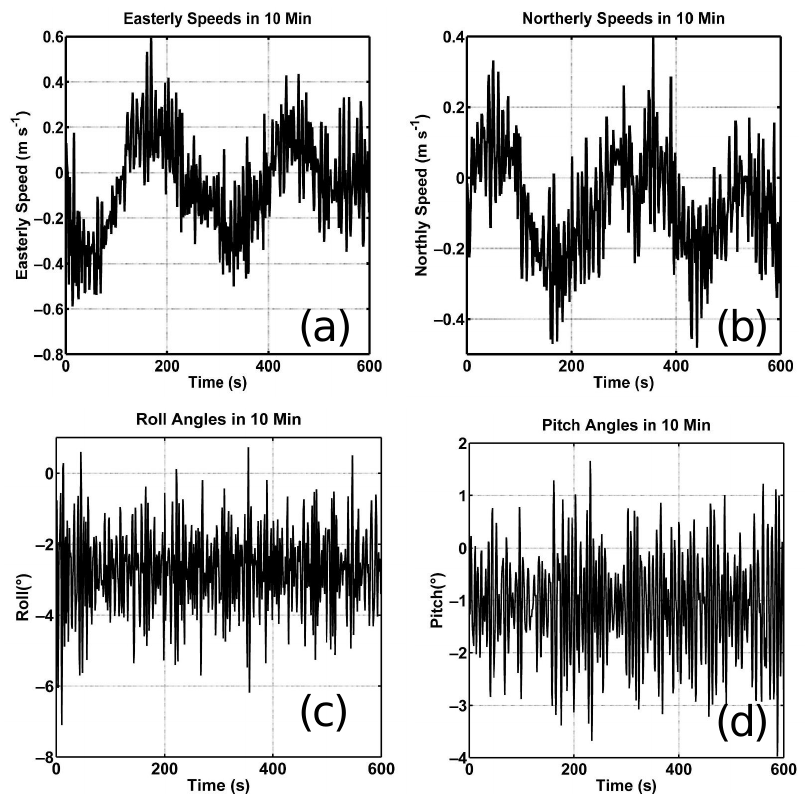
Figure A1. In the first 10 min (time span 1 s): ( a ) easterly speeds, ( b ) northerly speeds, ( c ) roll angles, and ( d ) pitch